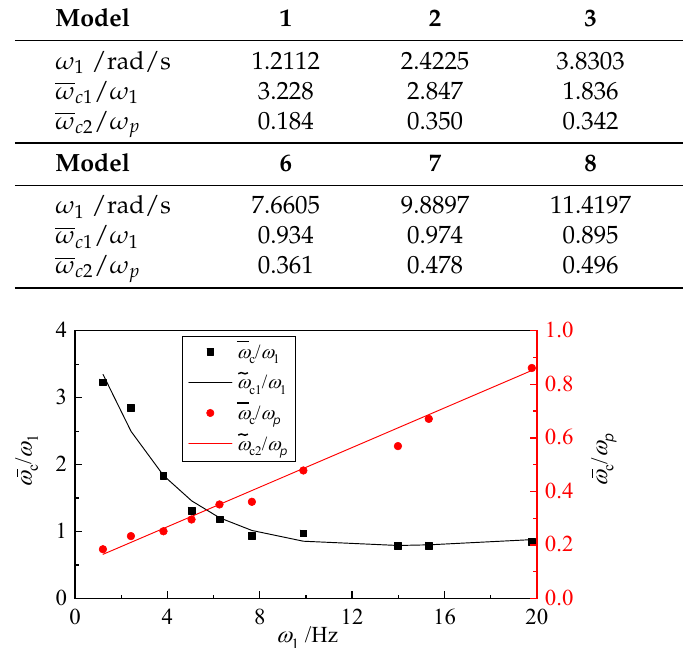
Figure 5. Fitting curves for optimal critical frequency (seismic